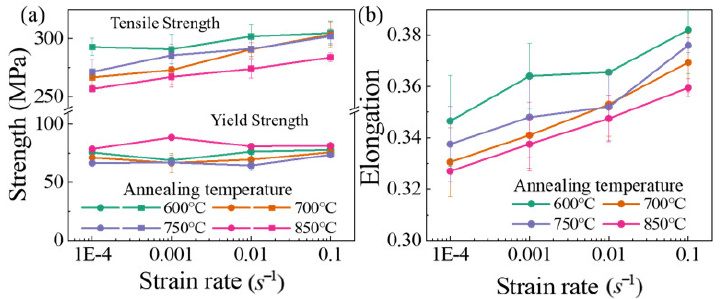
Figure 4. Mechanical properties of specimens at various strain rates: ( a ) strength, ( b ) elongation.